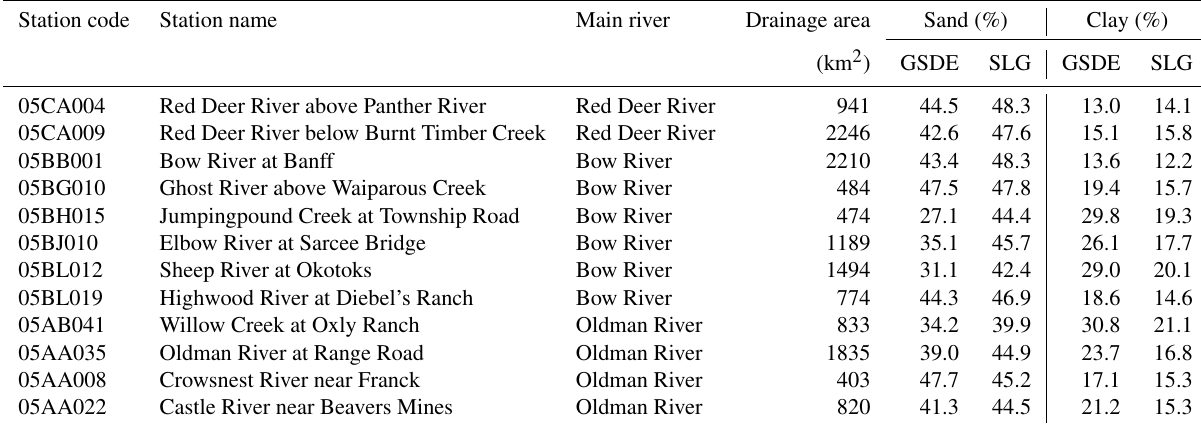
Table 1. Characteristics of the hydrometric stations used for model evaluation and mean soil texture fraction (top 50cm) per basin from the GSDE and SoilGrid (SLG)